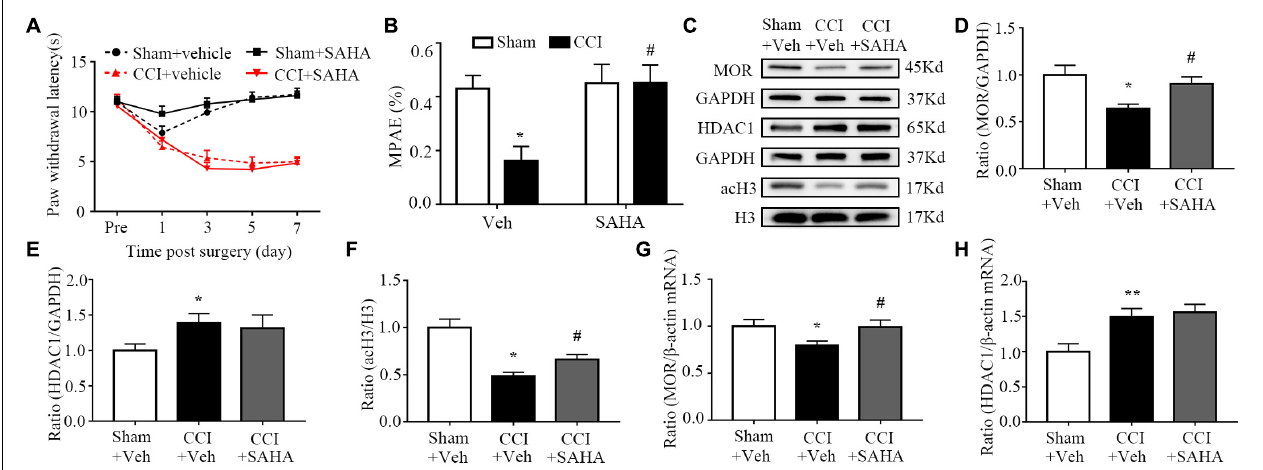
FIGURE 5 | SAHA increased the analgesic effects of morphine and MOR expression in the ipsilateral DRG in neuropathic pain mice. SAHA (50 mg/kg, i.p.) was used 30 min before surgery daily for 7 consecutive days. The day of surgery was set as day 0. PWL was measured 30 min after treatment with morphine (1.5 mg/kg, s.c.) on day 7. WB and qRT–PCR were used to measure protein expression on day 7. (A) Effects of i.p. SAHA or vehicle on paw withdrawal latencies (PWL) to heat stimuli on the ipsilateral sides at the different days. Two-way RM ANOVA followed by post hoc Tukey test. F group (3, 165) = 124.4. (B) The morphine MPAEs measured 30 min after subcutaneous injection of 1.5 mg/kg morphine after SAHA or vehicle treatment from CCI and or sham surgery on day 7. n = 12 mice/group. Two-way ANOVA followed by post hoc Tukey test. F group (1, 44) = 4.485. * p < 0.05, versus the sham plus vehicle group, # p < 0.05, versus the CCI plus vehicle group. (C–F) Expression of MOR, HDAC1 and acH3 proteins in the ipsilateral L3–5 DRGs after SAHA or vehicle treatment from the CCI and or sham group. n = 6 biological repeats (18 mice)/group. One-way ANOVA followed by post hoc Tukey test. F group (2, 15) = 5.593 for MOR, F group (1, 15) = 2.056 for HDAC1, F group (2, 15) = 16.3 for acH3. * p < 0.05, versus the sham plus vehicle group; # p < 0.05, versus the CCI plus vehicle group. (G,H) Levels of MOR and HDAC1 mRNAs in the ipsilateral L3–5 DRGs on day 7 after i.p. SAHA or vehicle treatment from CCI and or sham mice. n = 7 biological repeats (14 mice)/group. One-way ANOVA followed by post hoc Tukey test. F group (2, 18) = 3.162 for MOR, F group (2, 18) = 7.065 for HDAC1. * p < 0.05, ** p < 0.01, versus the sham plus vehicle group; # p < 0.05, versus the CCI plus vehicle